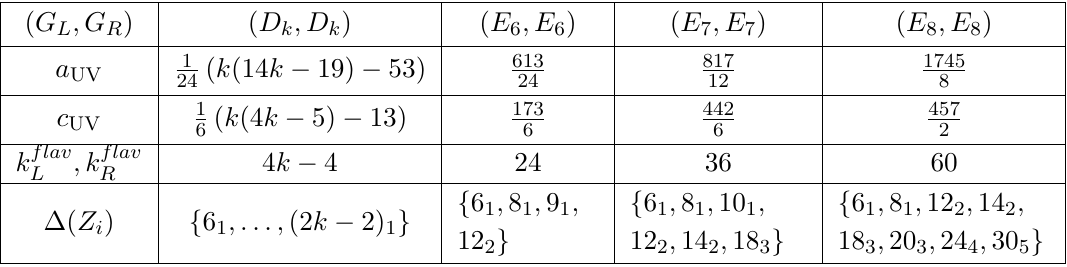
Table 5. Anomalies and scaling dimensions for 4D N = 2 ( G; G ) conformal matter. In the last row, the subscripts are the multiplicities, i.e. the number of Coulomb branch operators with that speci(cid:12)c scaling